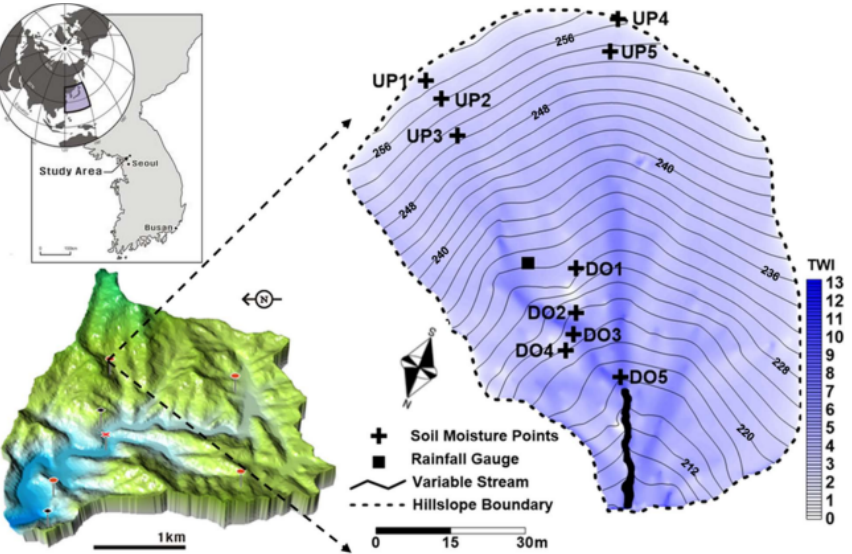
Figure 1. Location of the Sulmachun watershed in South Korea with hydrologic monitoring (rainfall and evapotranspiration) stations (lower left) and study area with terrain contours, topographic wetness index (TWI), and soil moisture monitoring points